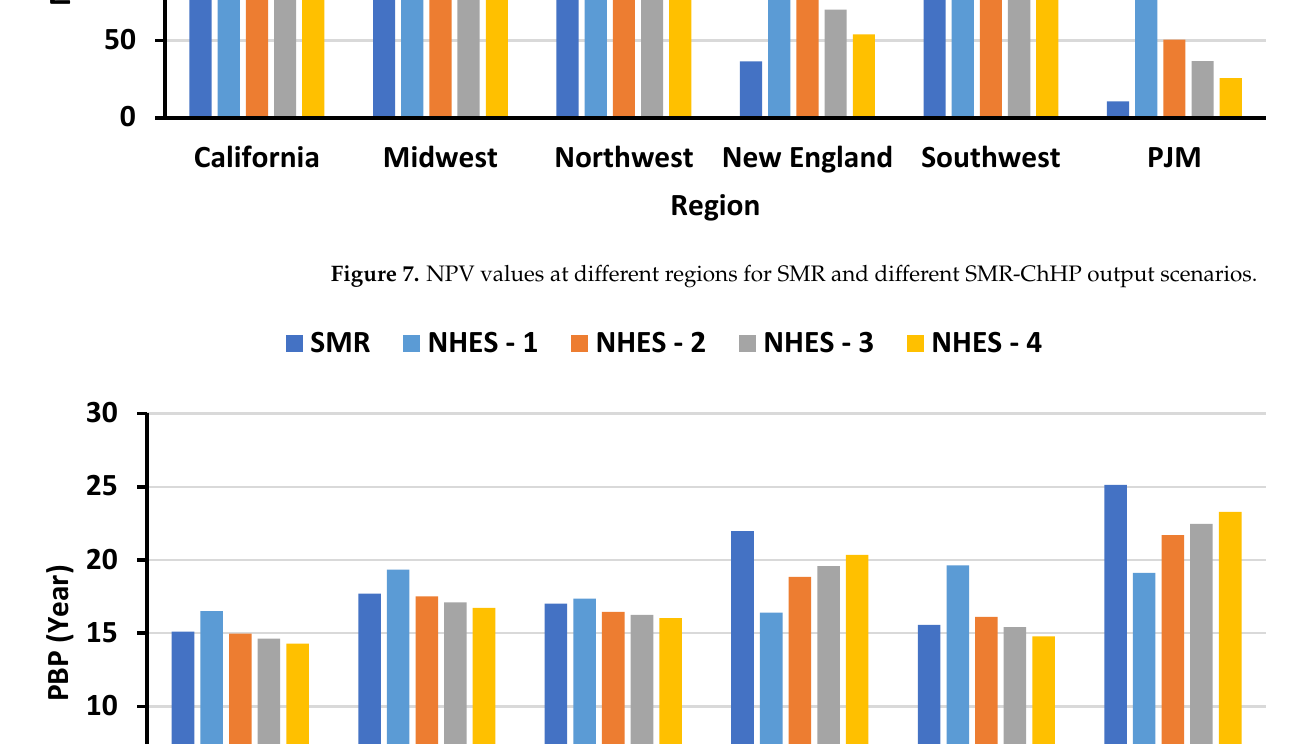
Figure 9. Percentage deviation of PBP for different NHES scenarios from SMR values . The DCFR calculations are shown in Figure 10, and all the NHES systems have DCFR values greater than WACC asserting the project is acceptable, and then it should be com- pared with other accepted scenarios or projects as per Bolden 2015. The DCFR values for New England and PJM are significant higher for NHES-1 system compared to advanced SMR making it the most profitable case for selling heat. Figure 11 shows the percentage deviation of DCFR for different NHES systems from advanced SMR values. The four cases where DCFR values of NHES systems are less than advanced SMR values are California, Midwest and Southwest for NHES-1 system and NHES-2 for southwest system. The DCFR analysis also confirmed that SMR-ChHP system is always profitable at different regions based on different ChHP thermal output scenarios.